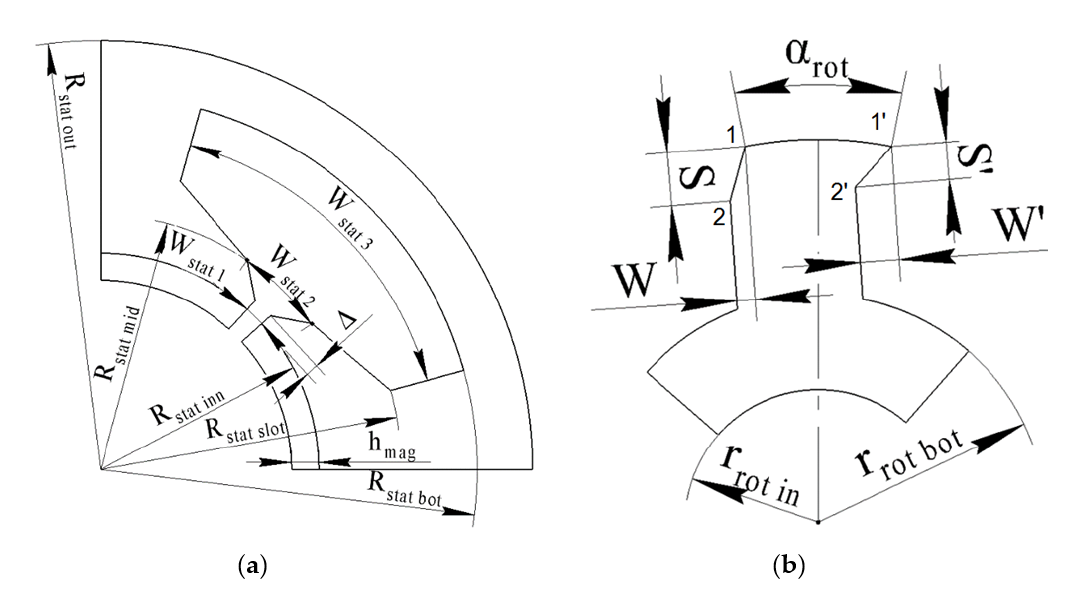
Figure 1. Motor design parameters: ( a ) stator; ( b ) rotor.